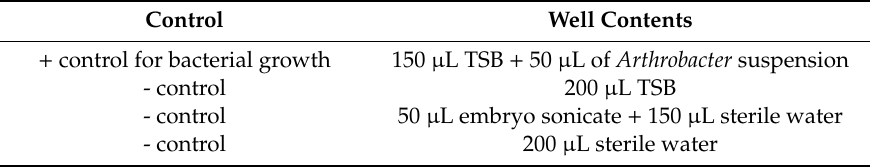
Table 3. Controls for the antimicrobial assay with embryo